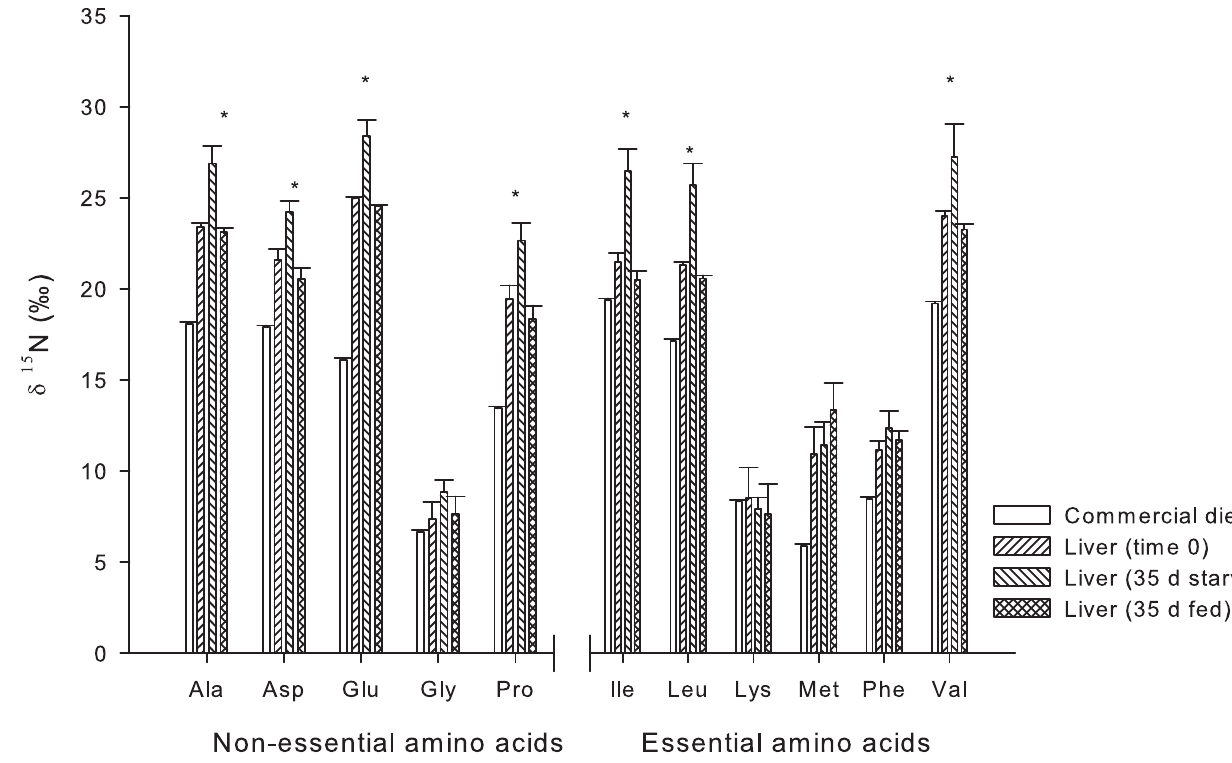
Fig 3. Compound specific δ 15 N of amino acids of of S . lalandi liver tissue: Commercial diet, Time 0, Liver 35 d starvation and Liver 35 d fed, averageand standard deviation. Asterix ( * ) denotesstatistically significantdifference betweentime 0 and 35 days of starvation.